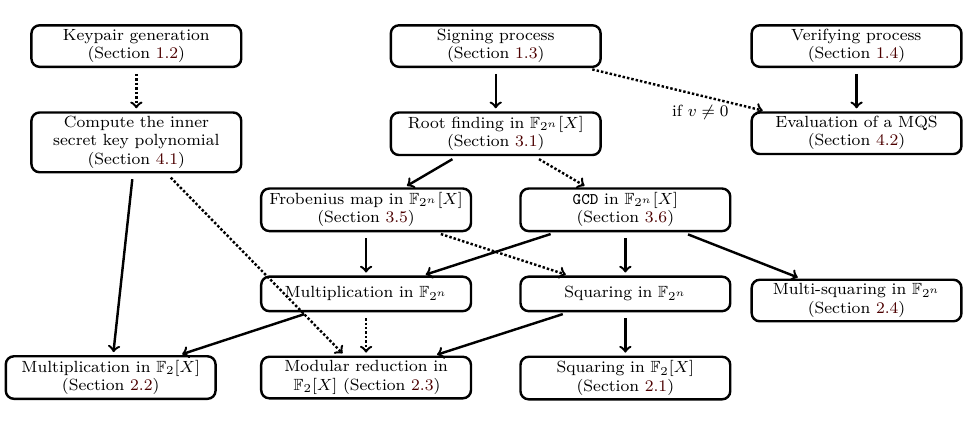
Figure 1: Dependencies between the different operations performed in MQsoft